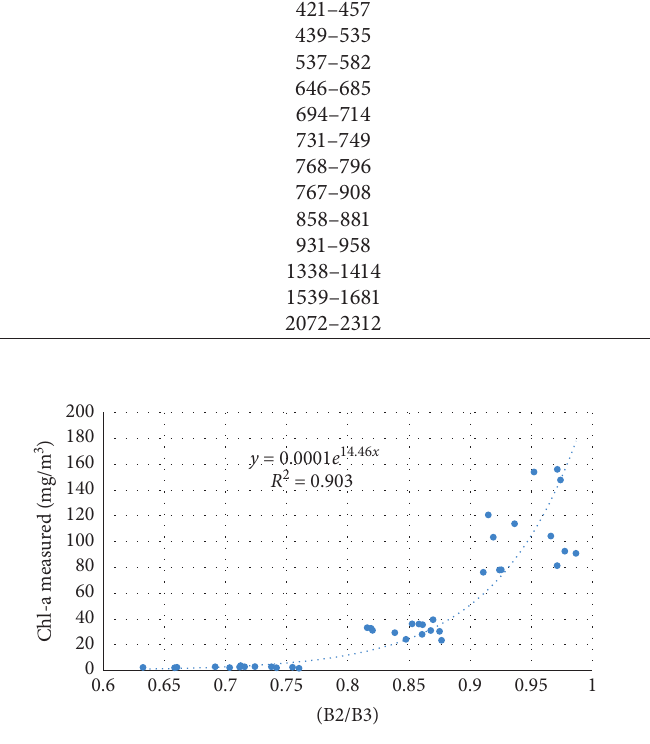
Table 5: Sentinel 2 spectral bands, spatial resolution, band range, and central wavelength at reference radiance used in this study. Band (spatial resolution)